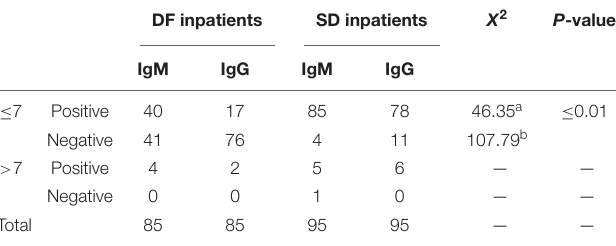
TABLE 3 | IgG and IgM antibodies for DENV detection in dengue